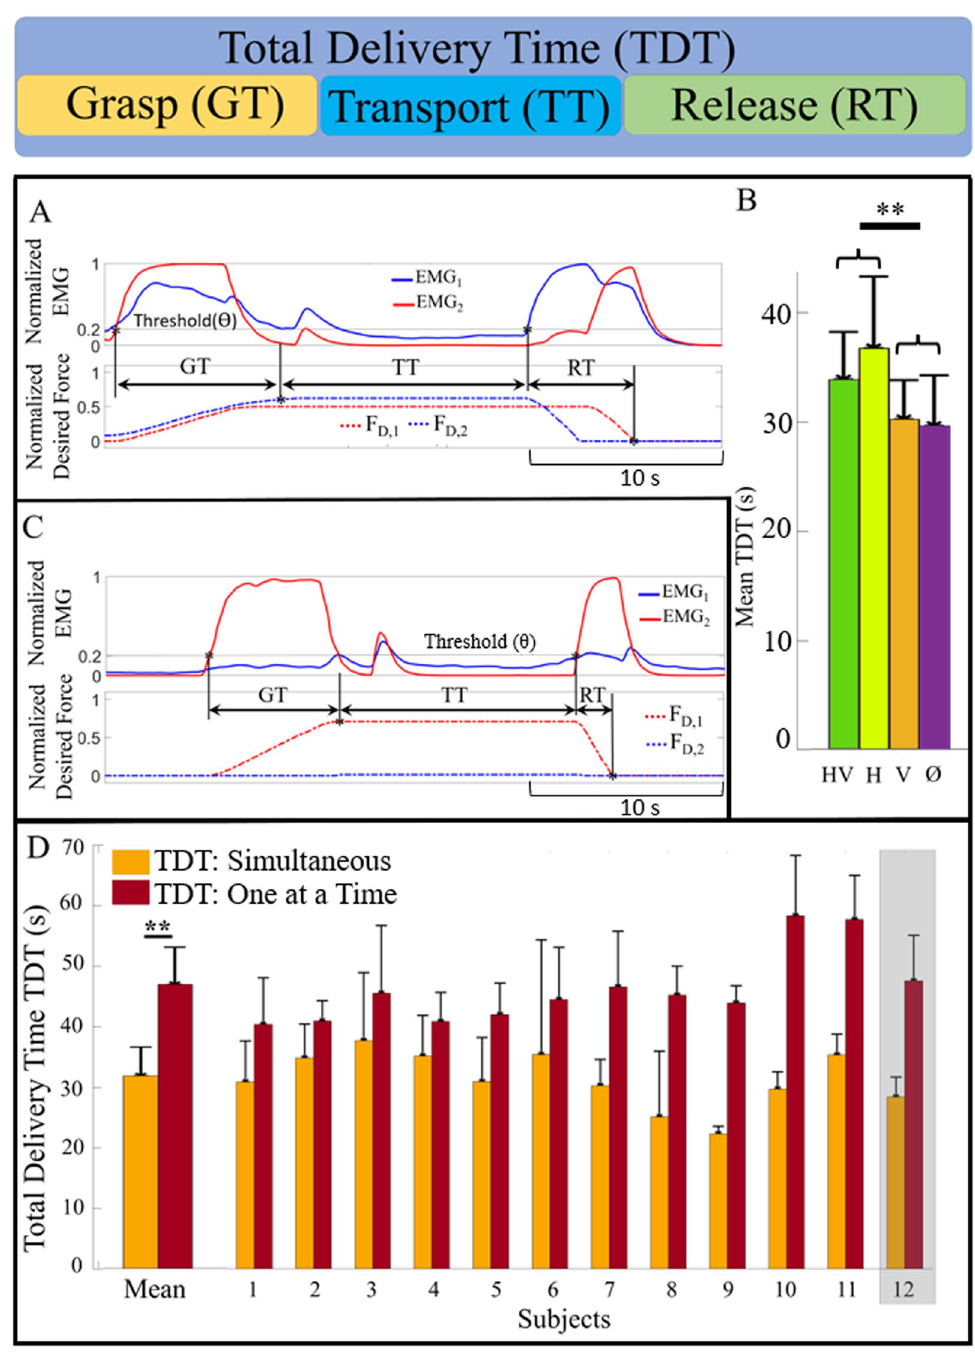
Figure 3. Comparison of total delivery time (TDT) to transport one object at a time versus two objects simultaneously. ( A ) Simultaneous control: The grasp time (GT), transport time (TT), and release time (RT) are illustrated in an exemplary dual-transport trial whose control signals are displayed at the subject level with the envelope of rectified EMG signals and at the robotic level with the desired forces F D used to control the artificial hand. ( B ) Mean TDTs of simultaneous control approach for four feedback conditions with haptic feedback (with Vision ‘HV’; without vision ‘H’) were significantly longer than both conditions without haptic feedback: visual feedback only (V) and neither visual nor haptic feedback ( ∅ ). ( C ) For comparison, an exemplary trial shows the control signals for transporting a single object. ( D ) Comparison of the mean TDT for both the single and simultaneous object transportation tasks showed significant improvement with the simultaneous control approach. Each subject, including limb-absent subject 12 demonstrated time efficiency with the simultaneous delivery of both objects. **p <